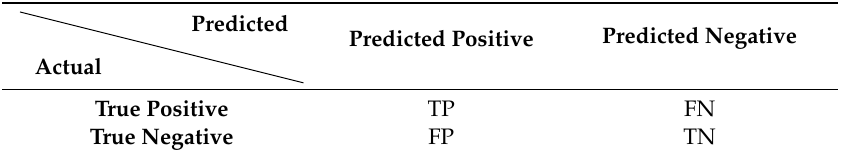
Table 2. Two-class confusion